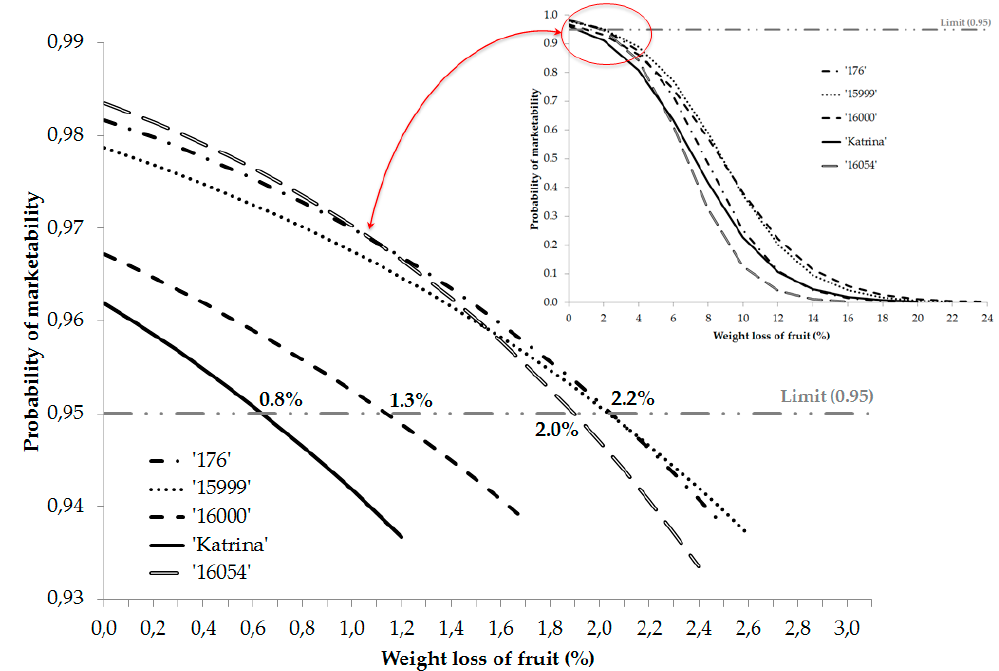
Figure 9. Probability of marketability based on fruit loss percentage during storage for the Galerno, Poniente, and Valle cultivars.